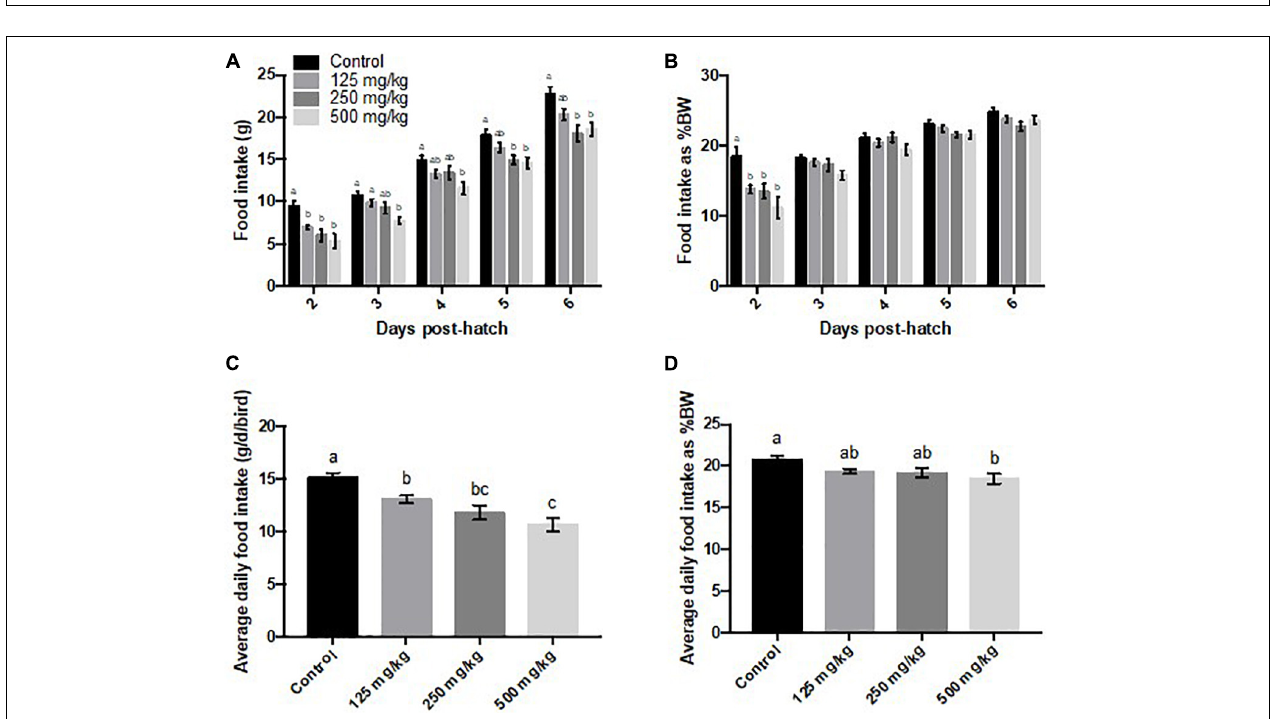
FIGURE 3 | Daily food intake (A) , food intake as a percentage of body weight [% body weight (BW)] (B) , average daily food intake (C) , and average daily food intake as % body weight (D) . Values represent least squares means ± SEM ( n = 12–13). Different superscripts within each day indicate a significant difference at P < 0.05; Tukey’s